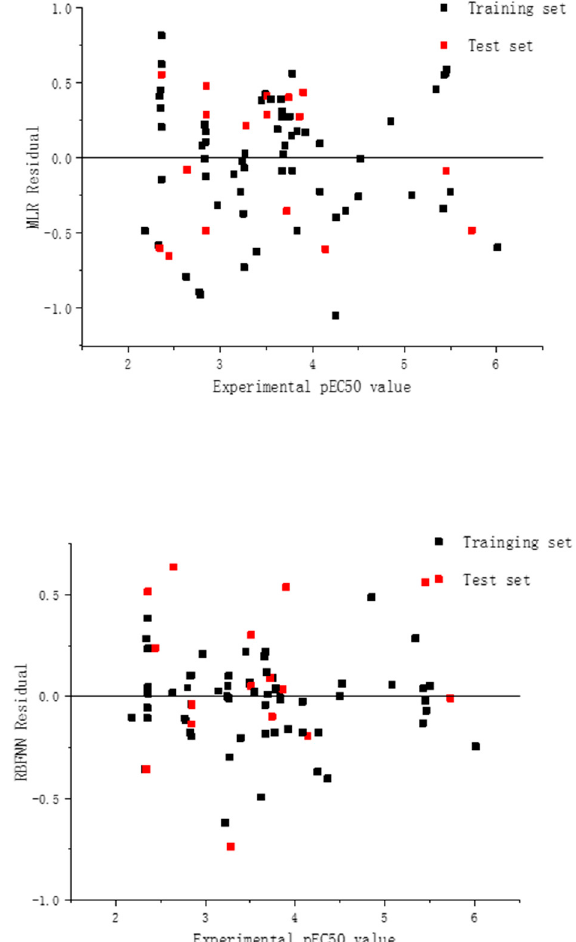
Figure 4. Residuals of the training and test sets by MLR and RBFNN . Table 4. The statistical results of the external test set for the MLR and RBFNNs models.